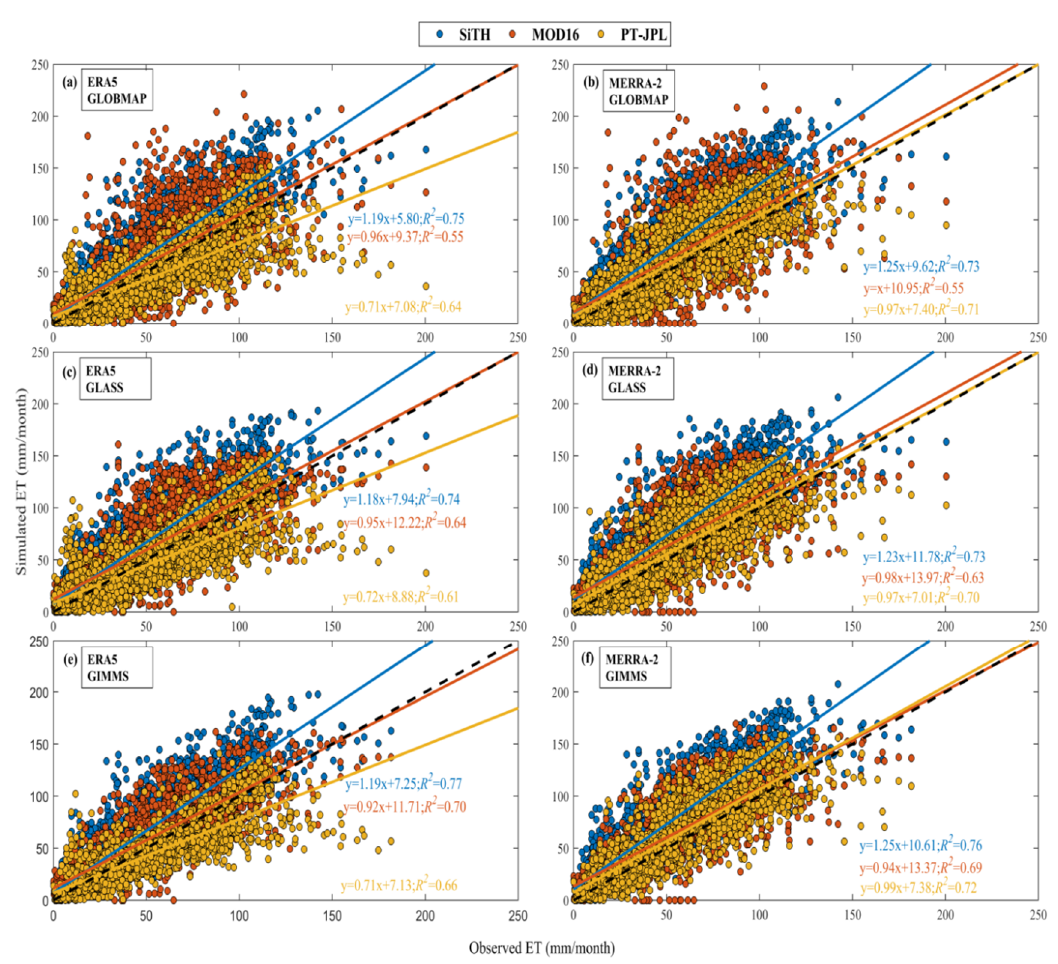
Figure 2. Scatter plots of the simulated evapotranspiration (ET) of three models using different forcing datasets versus measured ET at 43 flux sites. On the left panels, the same meteorological dataset of ERA5 and leaf area index (LAI) datasets of ( a ) GLOBMAP, ( c ) GLASS, and ( e ) GIMMS was used to simulate ET, respectively. On the right panels, the same meteorological dataset of MERRA-2 and LAI datasets of ( b ) GLOBMAP, ( d ) GLASS, and ( f ) GIMMS was used to estimate ET, respectively. The black dotted line represents the 1:1 line.